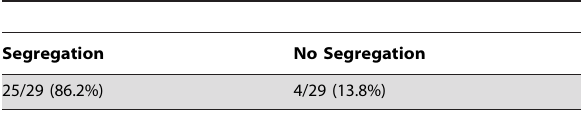
Table 1. Segregation of mitochondrial SLP-2-gfp from the cSMAC in the mature IS.